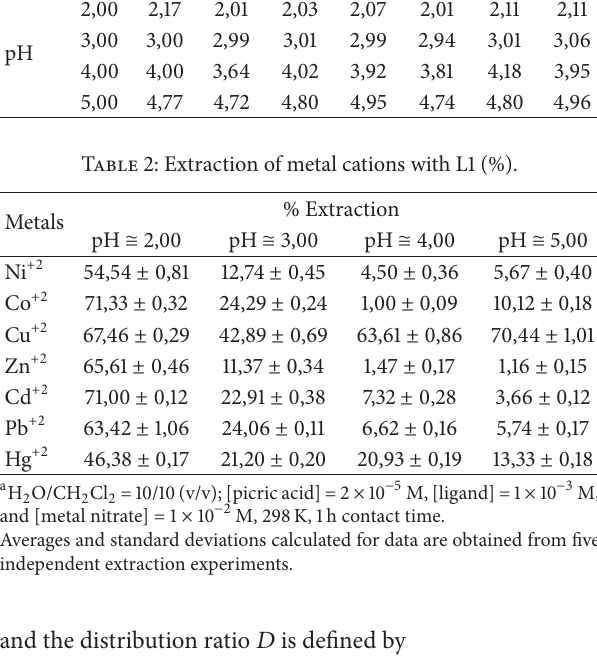
Table 1: Metal picrates and medium pH used in extraction.